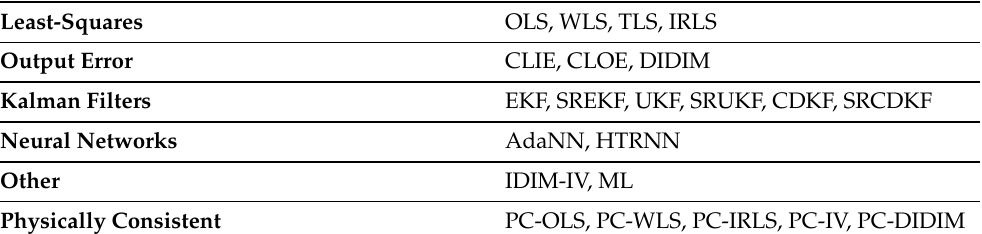
Table A1. Overview of the different identification methods implemented in this work.